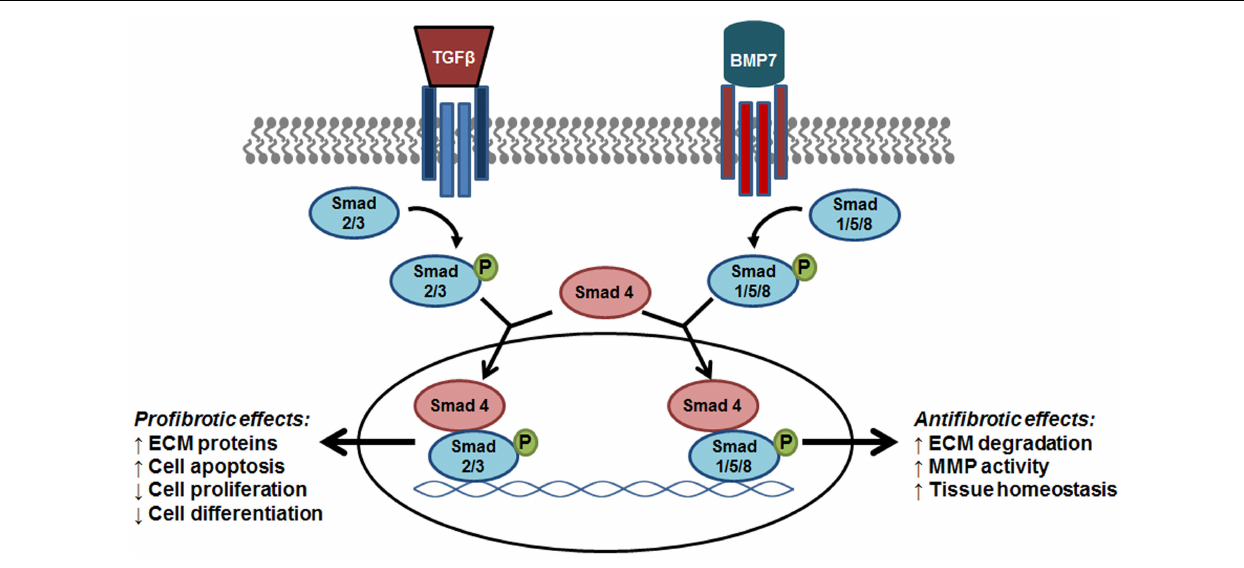
FIGURE 1 | The antifibrotic effect of BMP7/Smad signaling. As members of the same family, BMP7 and TGF- β trigger the phosphorylation of R-Smads that signal trafficking to the nucleus via Smad 4 for specific gene transcription. The phosphorylation of Smad 1/5/8 by BMP7 results in the transcription of target genes that oppose the fibrogenic effects induced by TGF- β -Smad2/3 signaling. BMP7, bone morphogenic protein; TGF- β , transforming growth factor- β 1; ECM, extracellular matrix proteins; MMP, matrix metalloproteinase; PAI-1, plasminogen activator